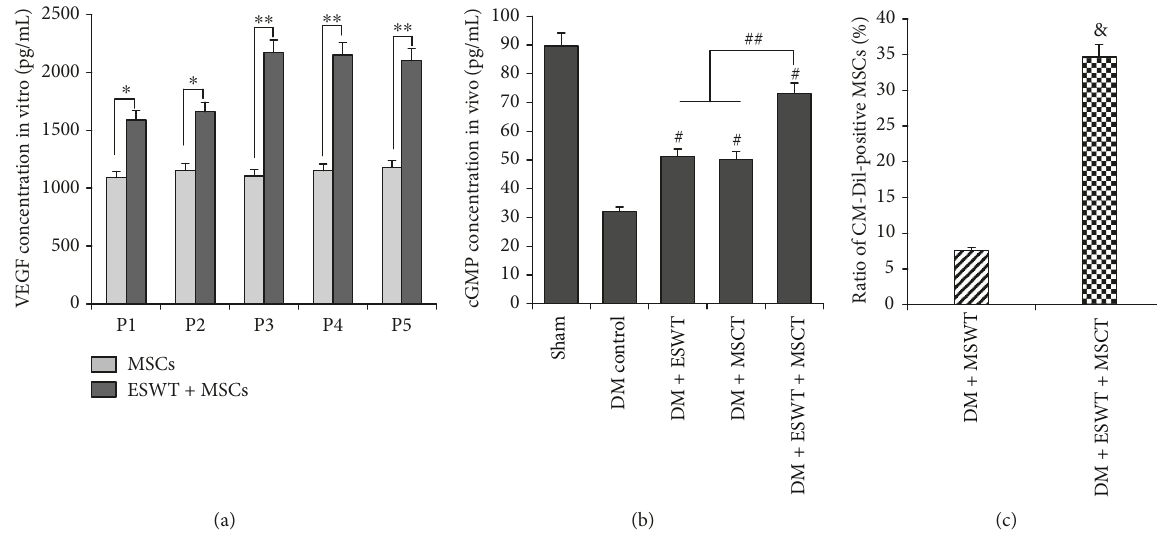
Figure 4: (a) VEGF concentration in vitro from P1 to P5 after ESWT or not, by ELISA. ∗ P < 0 05 , with untreated MSCs; treated MSCs secreted higher levels of VEGF. ∗∗ P < 0 01 , with untreated MSCs; treated MSCs secreted higher levels of VEGF. (b) cGMP concentration of each group in vivo, by ELISA. # P < 0 05 , with untreated MSCs; treated MSCs secreted higher levels of cGMP. # P < 0 05 compared with the DM control group. ## P < 0 05 compared with the DM+ ESWT and DM +MSCT groups. (c) Ratio of CM-Dil-positive MSCs in the corpus cavernosum. & P < 0 01 ; in the DM +ESWT+ MSCT group, the quantity of MSCs is higher than in the DM+ MSCT